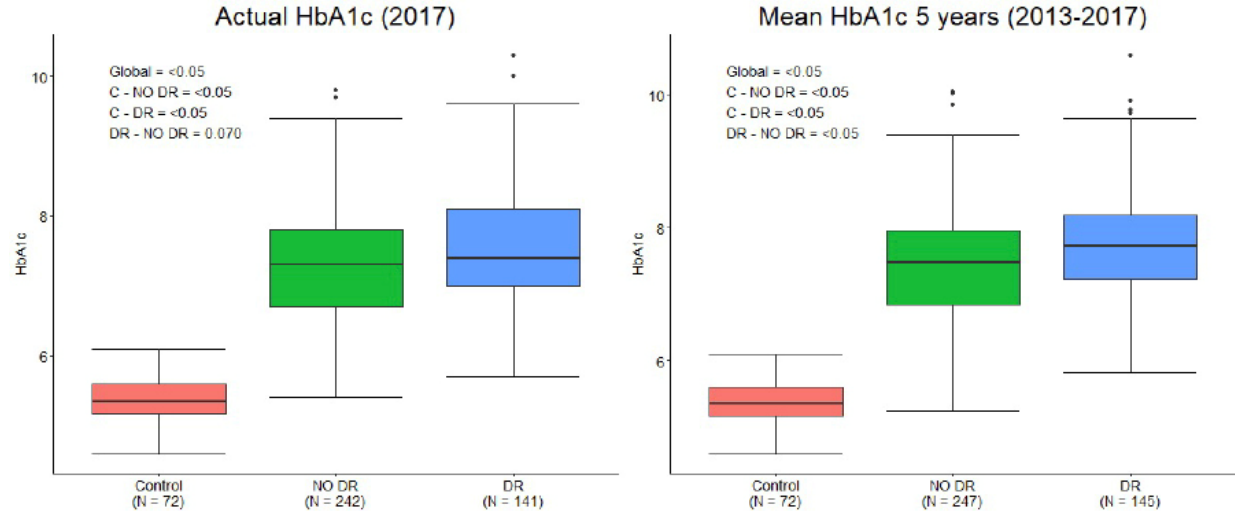
Figure 2. Glycated Haemoglobin (HbA1c) levels in study subgroups. Left : Actual HbA1c level at the retinal imaging timepoint (2017). Right : Mean HbA1c calculated from previous 5 years timepoints (2013 to 2017).